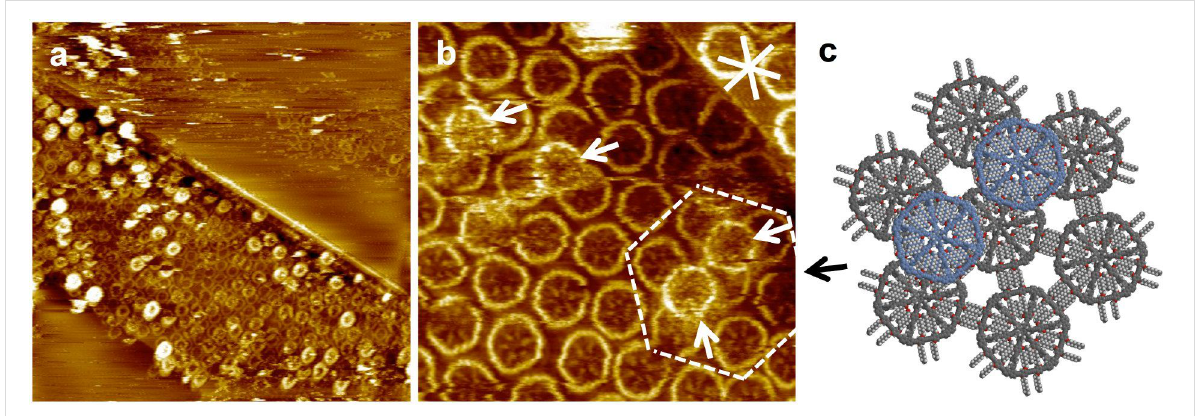
Figure 4: (a)–(c) STM images and a supramolecular model of MSW 2 at the OA/HOPG interface. (a) Overview STM image (200 × 200 nm 2 (internal scanner calibration), V S = − 1.4 V, I t = 5 pA). A several 10 × 10 nm 2 large region is covered by a monolayer and (partly) a multilayer, whereas large parts remain uncovered. (b) The more detailed STM image (40.5 × 40.5 nm 2 , V S = − 1.5 V, I t = 10 pA) shows MSWs that are adsorbed in a second layer on top of the centers of three supporting molecules (and indicated by white arrows). (c) Supramolecular model of the region marked by white dashed lines in (b). The first MSW monolayer (on HOPG) is shown in grey color, whereas the molecules in the second layer are shown in blue color (and their pseudo-extraannular alkoxy side chains are not shown). The molecules were adsorbed from a 10 − 5 M solution, and the sample was ther- mally annealed for 30 s at 80 °C prior to imaging. The white asterisk in (b) indicates the HOPG main axis